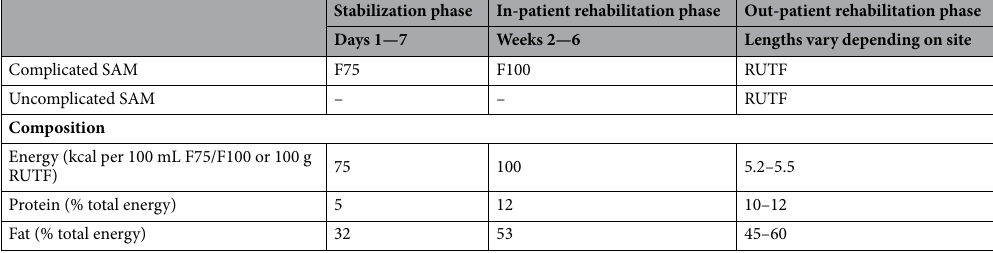
Table 3. Nutritional management protocol for children with severe acute malnutrition 39